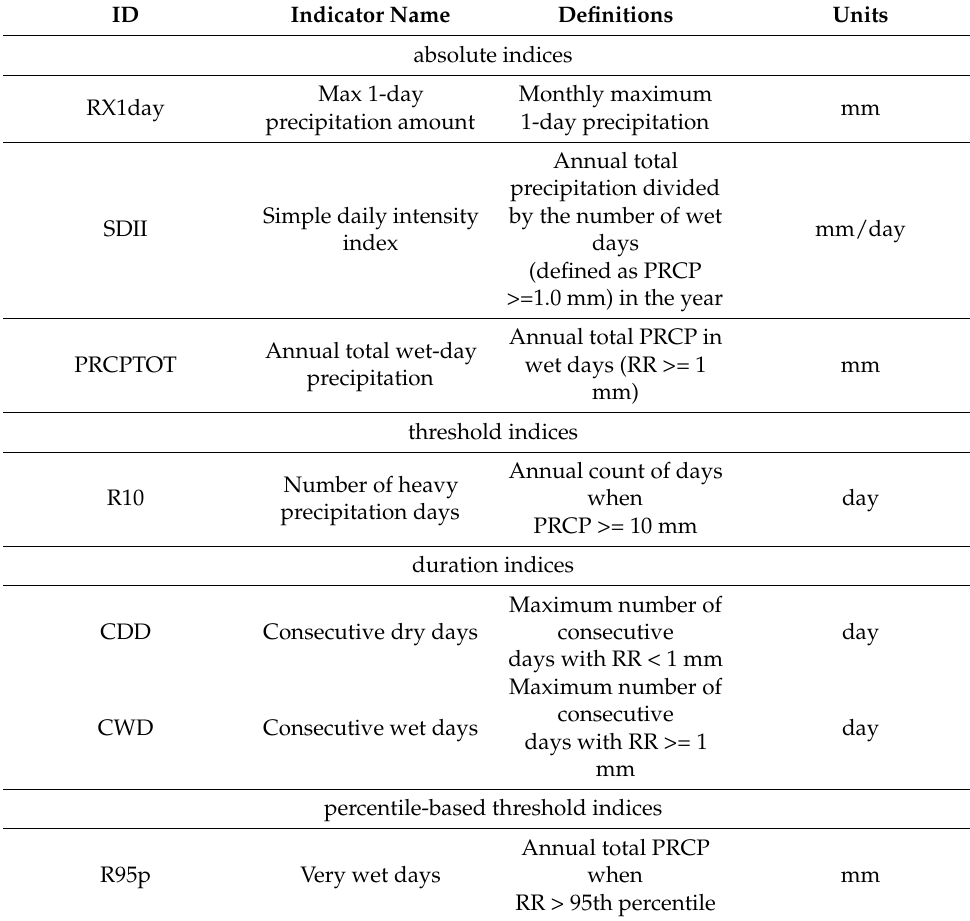
Table 1. Definitions of the precipitation